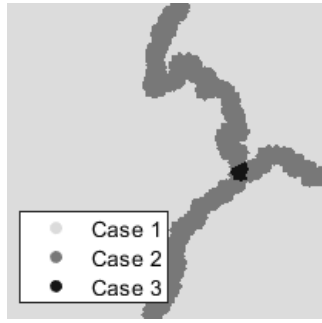
Figure 3. Three Cases Described In Proof: Depending on whether ( k , l ) falls within a transition region, and how many regions are in that transition, we see different bounds for our